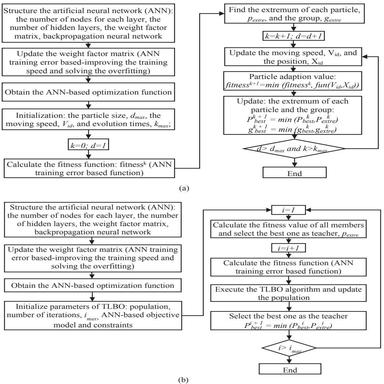
Flow chart showing the optimization process using (a) the PSO and (b) the TLBO, when implementing the machine learning based optimization function.